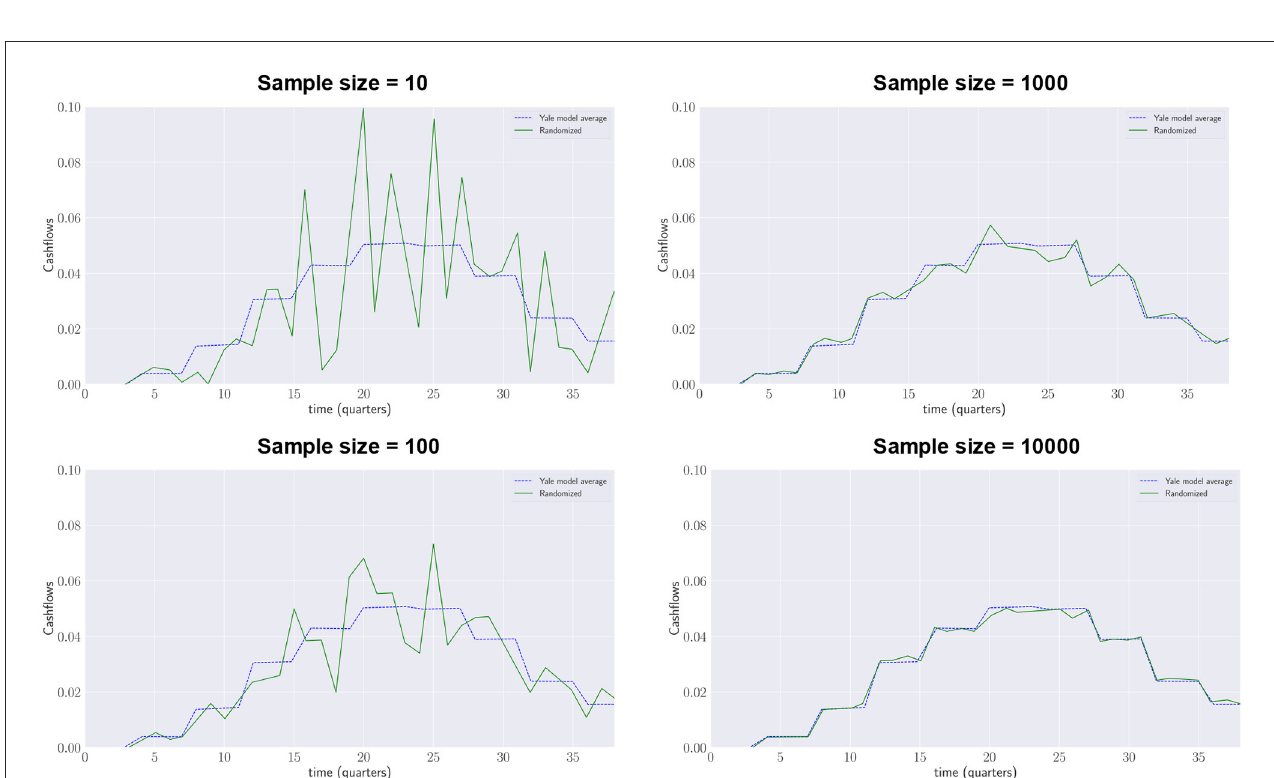
FIGURE5 Yale Plus model, quarterly